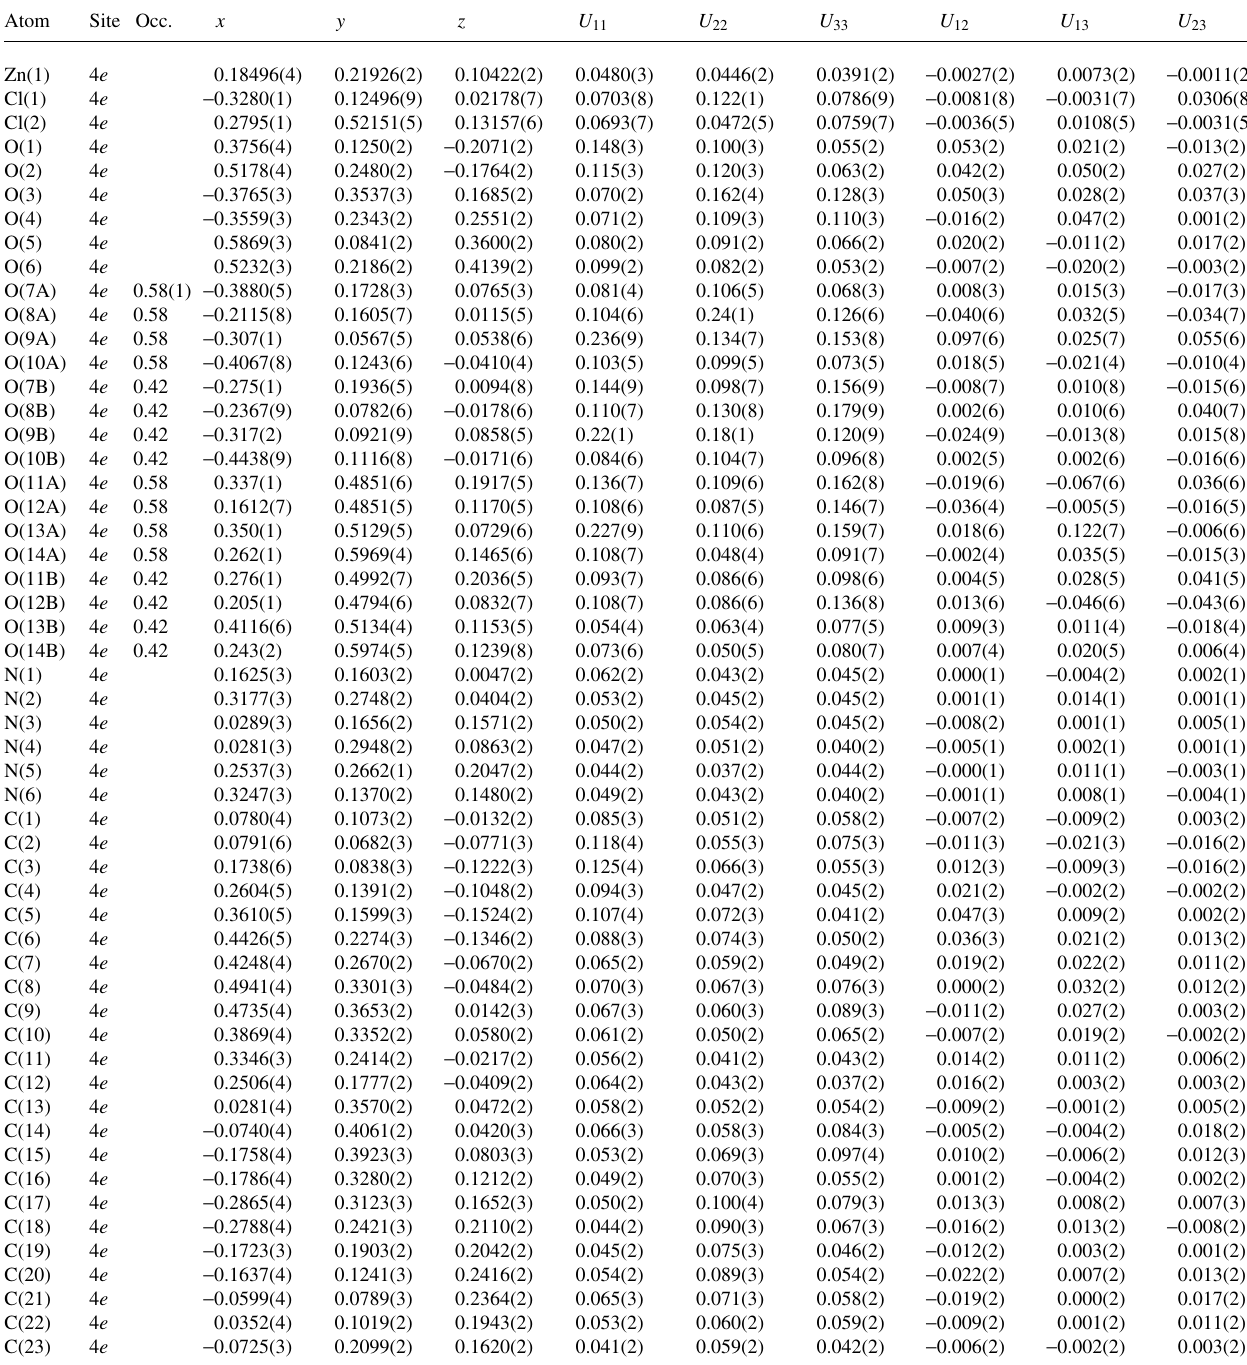
Table 3. Atomic coordinates and displacement parameters (in Å 2 )